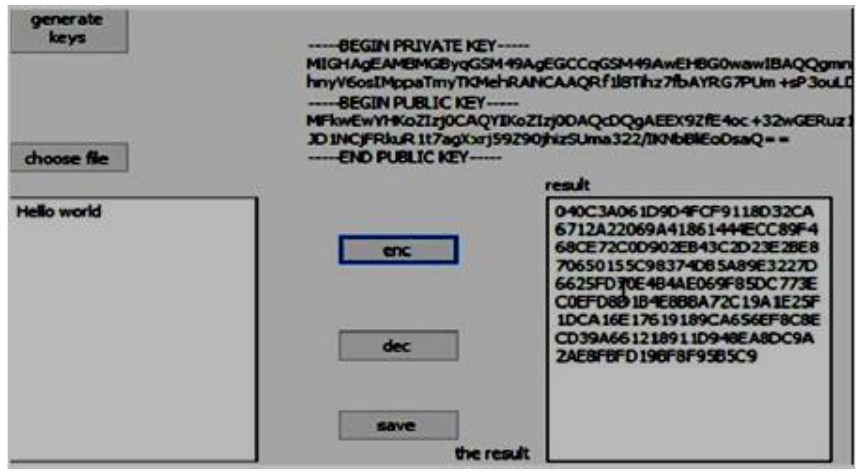
Figure 10. Encrypted file.